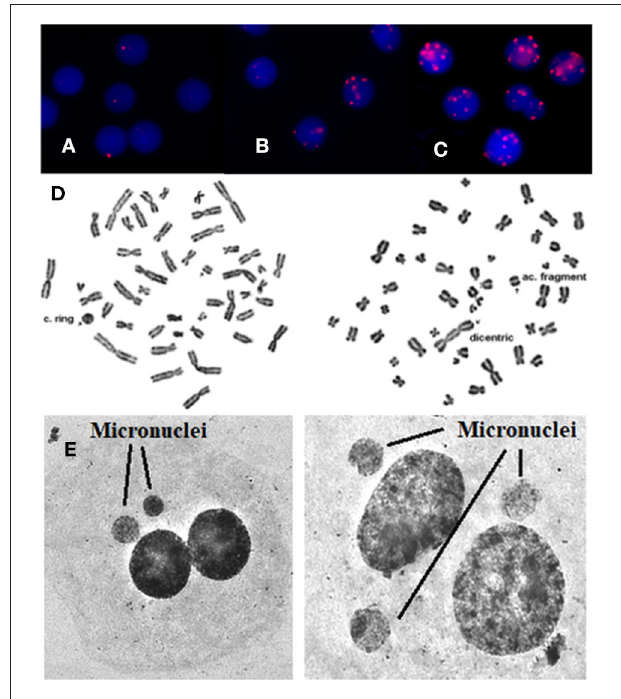
FIGURE 1 | γ -H2AX foci are visualized by means of immunofluorescence staining. (A) Before the exposure, (B) after in vivo exposure, (C) after in vitro irradiation with 1Gy, (D) using Giemsa staining, rings, and dicentric chromosomes can easily and accurately be detected and quantified in patients’ blood samples. Arrows indicate chromosome aberrations. On the left there is a centric ring with acentric fragment and on the right there is a dicentric chromosome with acentric fragment, (E) using Giemsa staining: micronuclei can easily and accurately be detected and quantified in patients. Arrows indicate